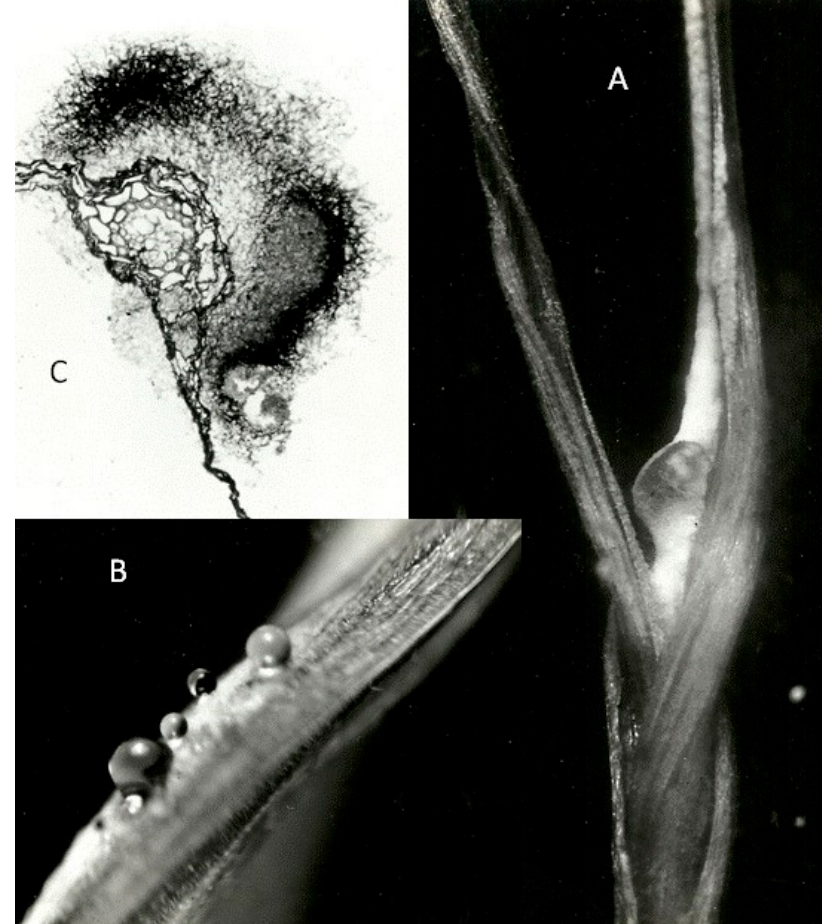
Figure 2. C. purpurea infection in an expanding leaf 3 weeks after inoculating the plumule of a germinating rye seed: ( A ) lateral view of dark pigmented lesion on the first leaf emerging from the coleoptile; ( B ) honeydew exudate associated with the white hyphae of sphacelial fructification on the first leaf; ( C ) unstained transverse section of leaf through ‘ergot’ lesion showing dark pigmented fungal cortex and a sphacelial sorus surrounding the leaf’s vascular tract.